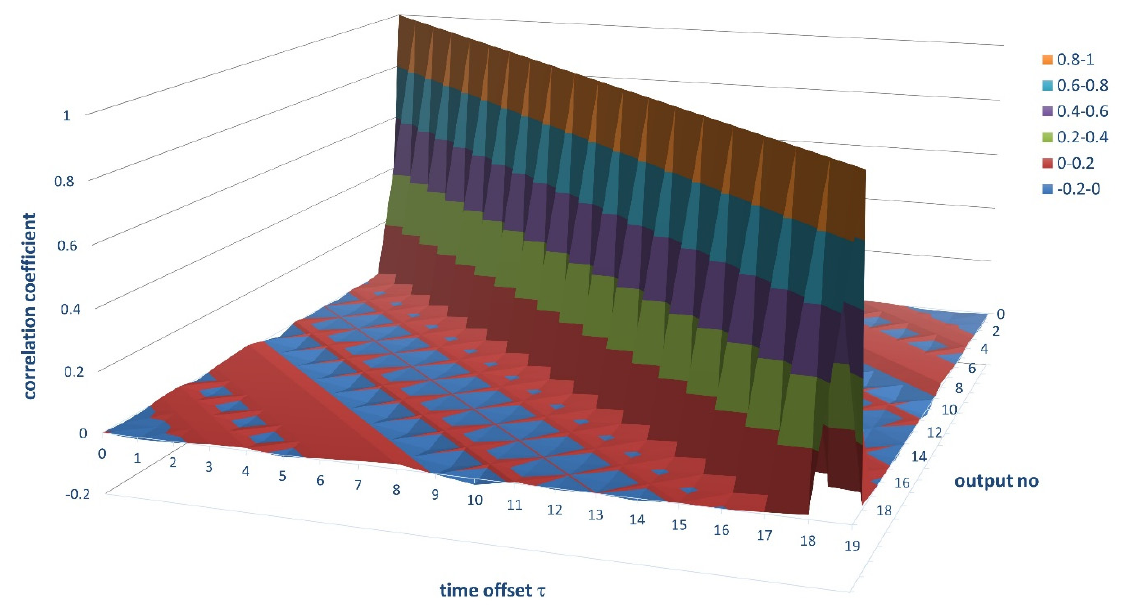
Figure 4. The graph for the correlation coefficient for an example of the type I LFSR register shown in Figure 3a.